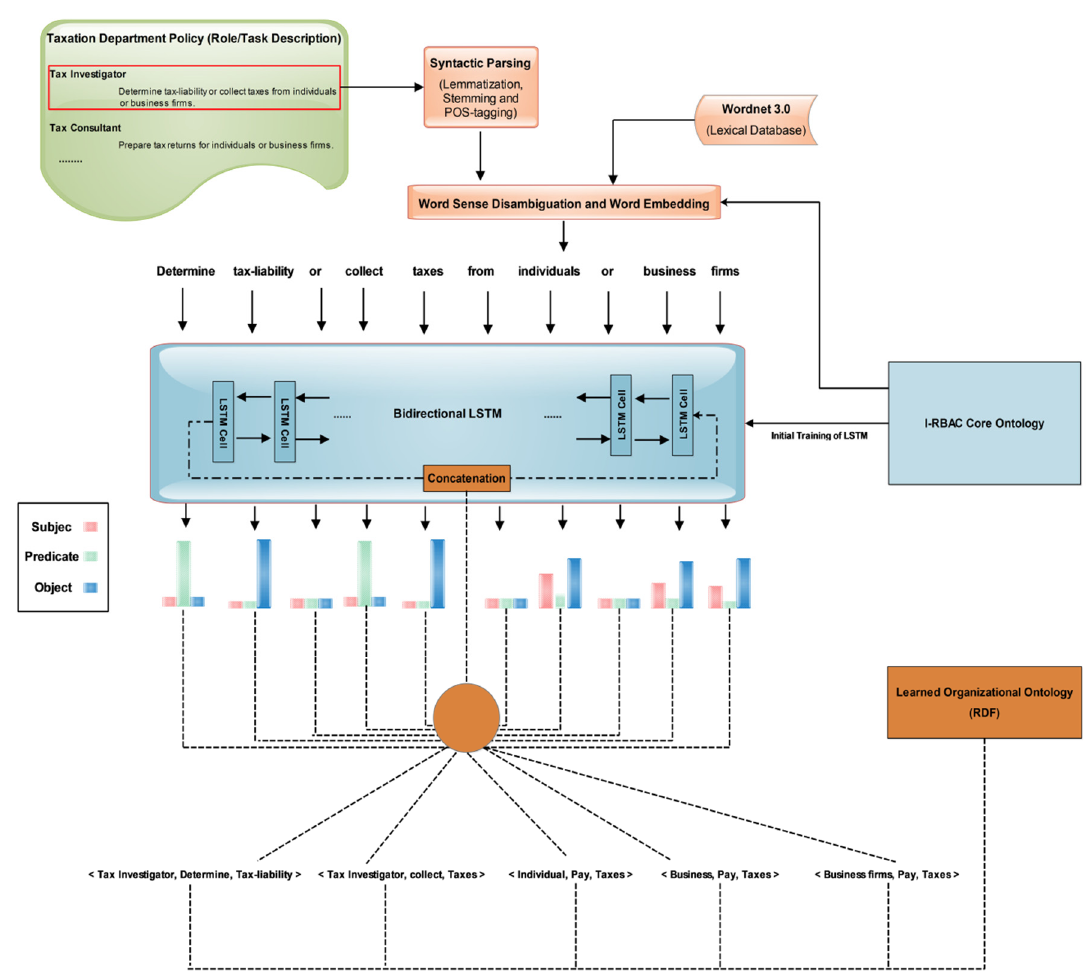
Figure 2. Automated population of organizational ontology from policy text.